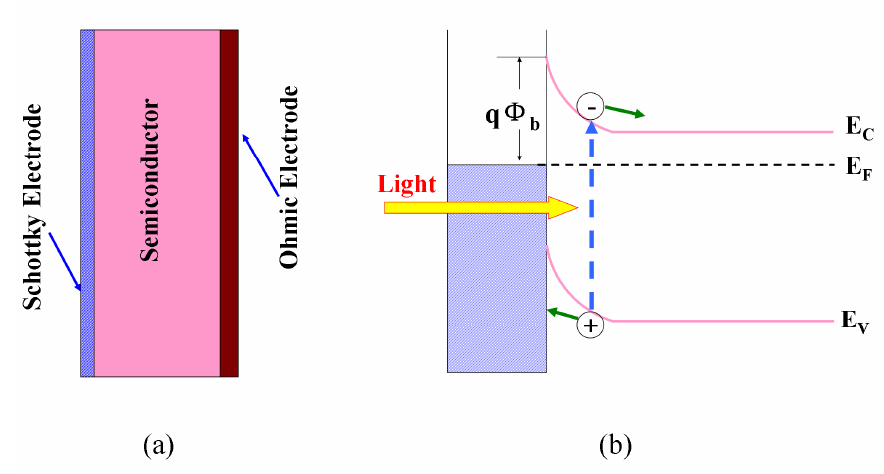
Figure 7. The schematic structure (a) and operation (b) of the Schottky